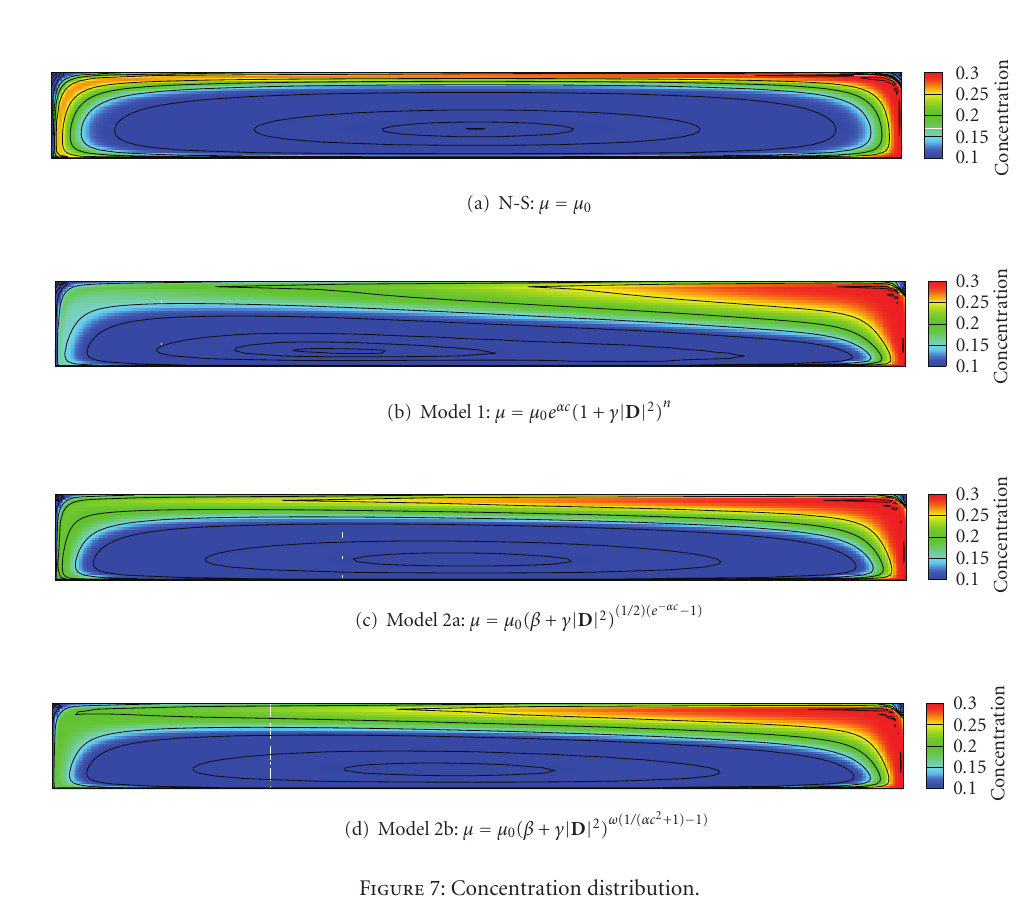
Figure 6: Comparison of velocity profiles on y - and x -cuts.